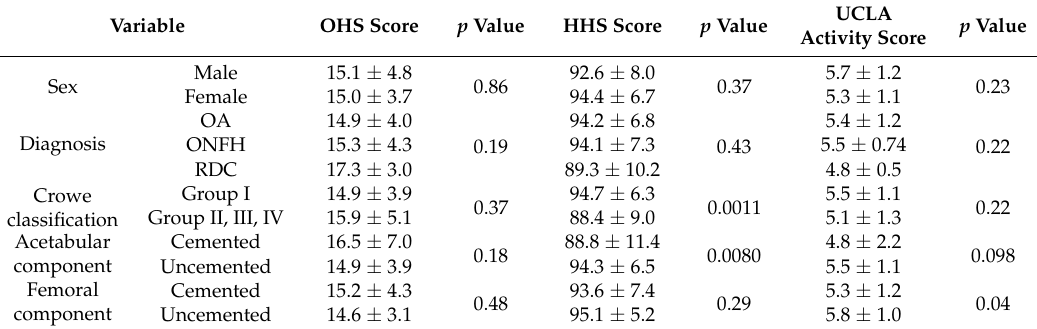
Table 6. Clinical scores 12 months after total hip arthroplasty.